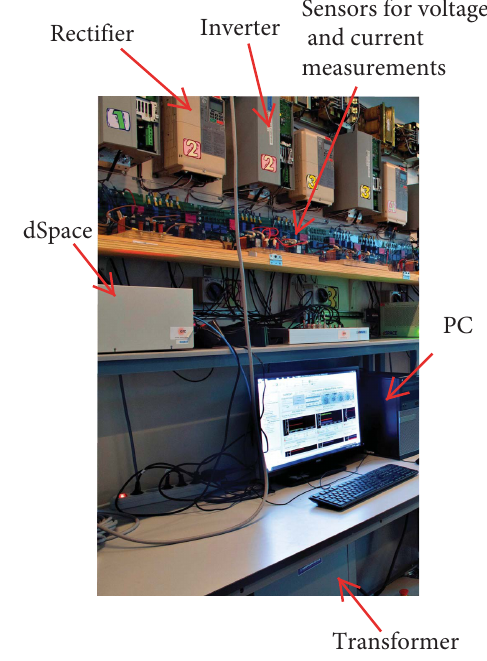
Figure 7. Experimental setup.